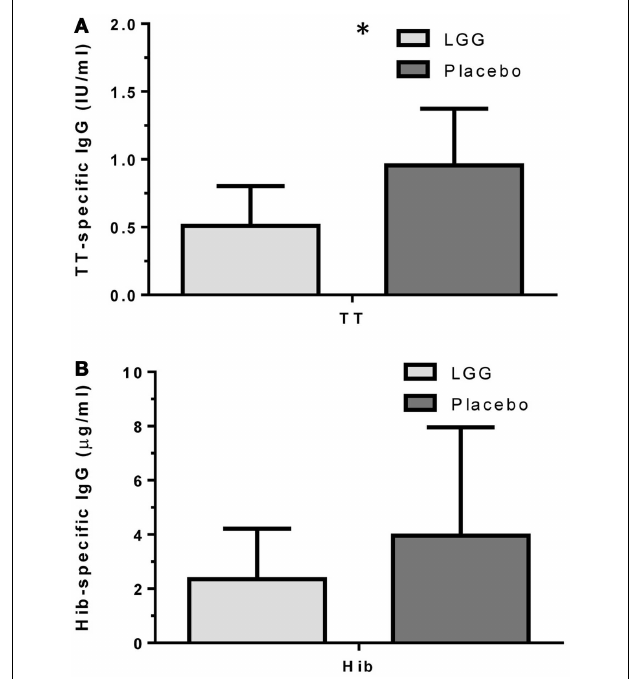
FIGURE 3 | Levels of (A) anti-TT IgG and (B) anti-Hib IgG (GMC ± 95% CI) for infants in the LGG ( N = 31) or Placebo ( N = 30) groups following TT and Hib immunization . * p < 0.05 comparing LGG and Placebo treatment.